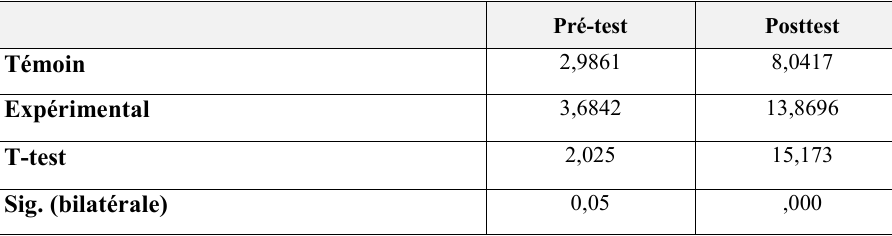
Tableau 4 : Résultats du